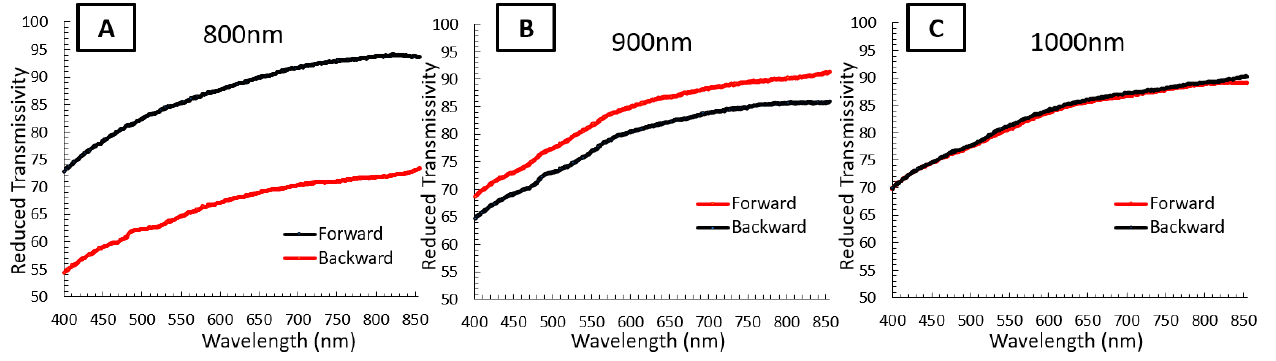
Figure 3 . Spectrophotometer measurements for forward and backward spectral transmissivity for ( A ) 800 nm, ( B ) 900 nm, and ( C ) 1000 nm periodicity sample. Experimental error is ±3%.